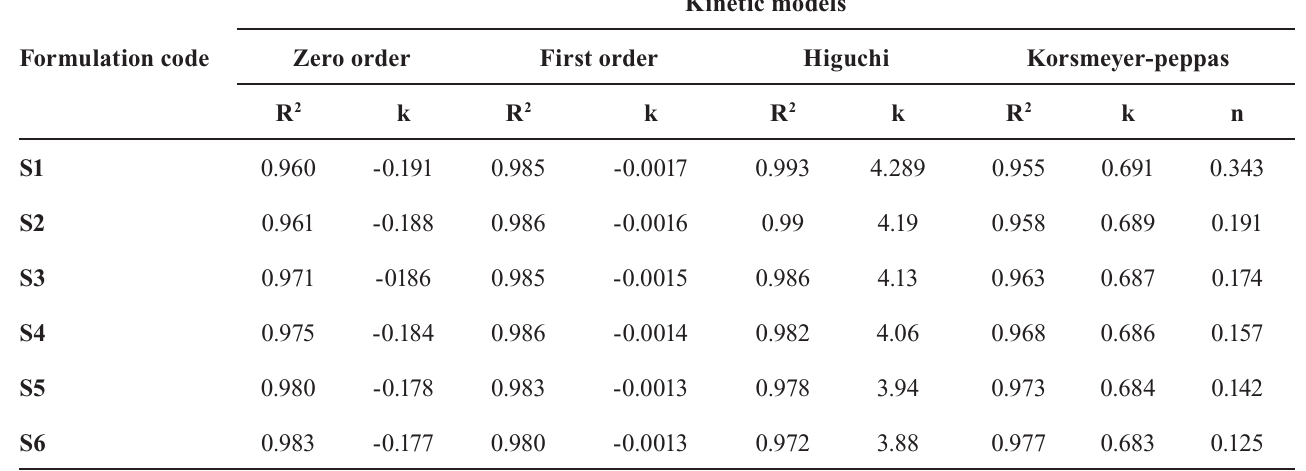
Formulation code